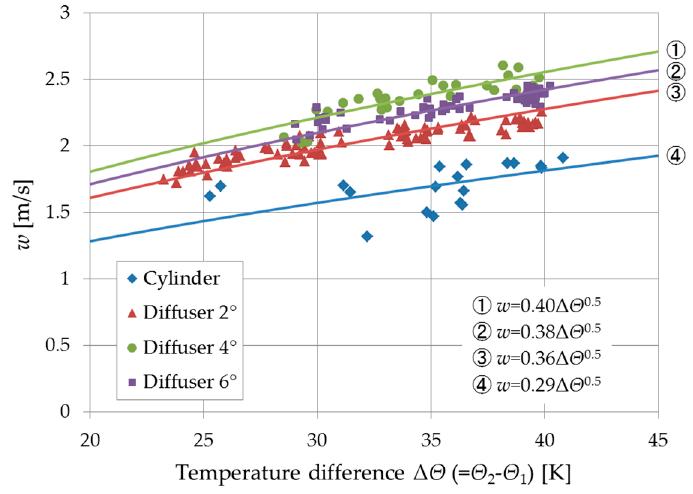
Figure 6. Updraft wind speed w vs. temperature difference ∆Θ for diffuser model with tower height 2 m for each semi-open angle of 0° (cylinder), 2°, 4° and 6°.